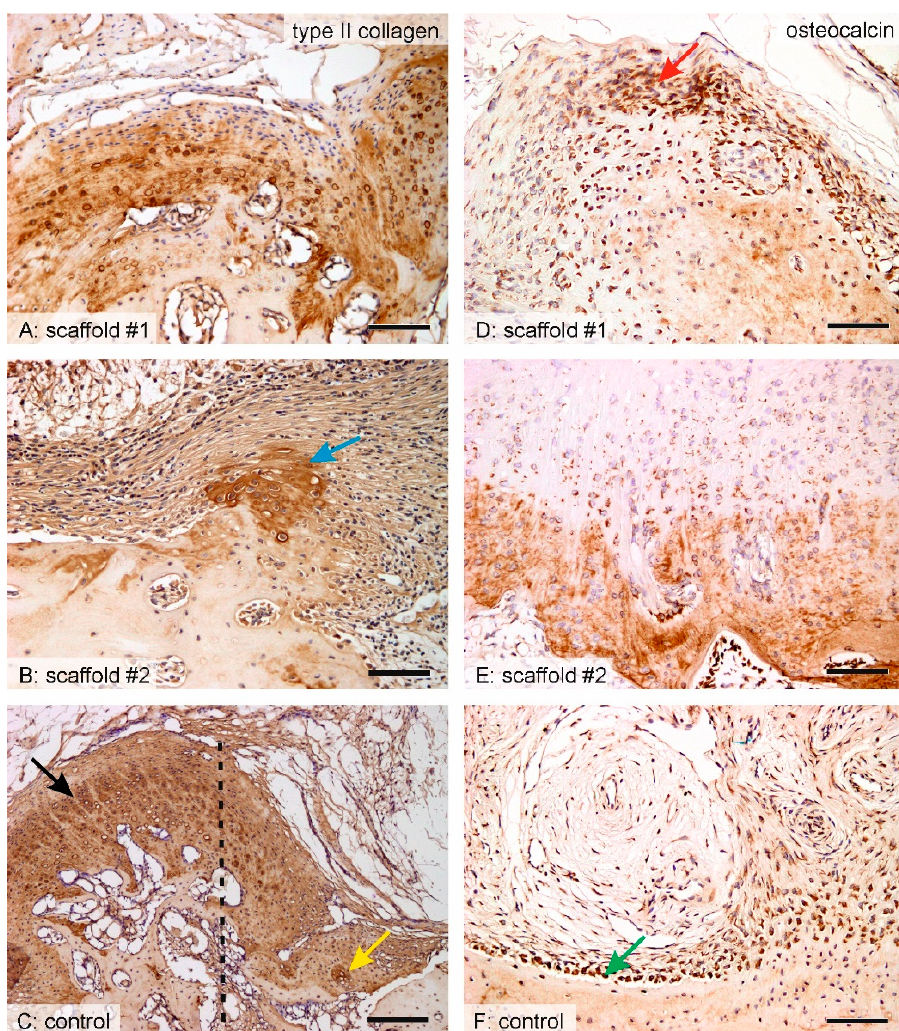
Figure 8. Comparing the histology of healing with scaffold #1, scaffold #2, and without a scaffold using type II collagen and osteocalcin immunohistochemistry. The microphotographs show the central part of the defect ( A , B , D – F ) or the peripheral part of the defect ( C ). A—In samples with scaffold #1, type II collagen-positive regions of hyaline cartilage were distributed in various regions of the defect, but mostly adjacent to the bone. D—In samples with scaffold #1, the surface of the bone was usually covered with osteocalcin-positive osteoblasts that were sometimes arranged in groups (red arrow). B—In samples with scaffold #2, only small islets of hyaline cartilage (blue arrow) were found. E—In samples with scaffold #2, the wall of the defect contained bone trabeculae with osteocalcin-positive bone matrix protruding into the defect and covered by osteoblasts. C—In control samples, the newly formed type II collagen-positive cartilage within the defect (yellow arrow) was only found close to the wound margins (dashed line, defect is on the right side of the image) and they were continuous with the articular cartilage outside the defect (black arrow). F—In control samples, most of the bone at the bottom and on the sides of the defect was covered by a single layer of osteocalcin-positive osteoblasts (green arrow). Immunohistochemistry for type II collagen (left) and osteocalcin (right) displayed a positive reaction in dark brown, counterstaining Gill’s hematoxylin. Scale bar: 100 µm (A, B, C right) and 200 µm (C left).